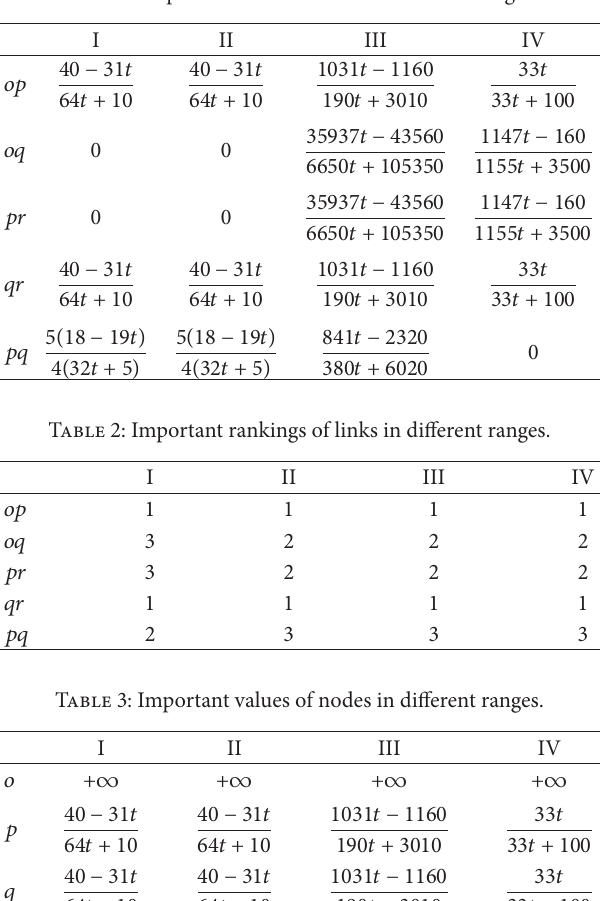
Table 1: Important values of links in different ranges.